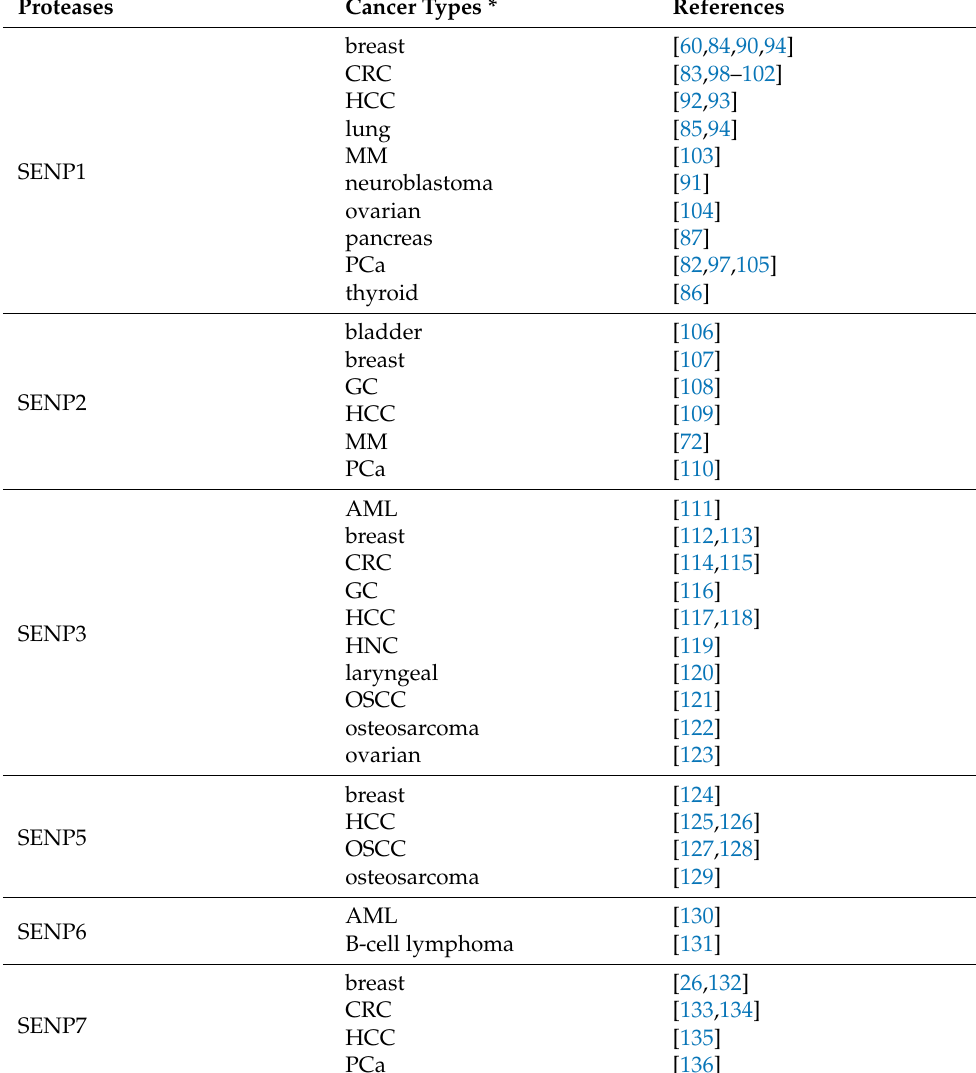
Table 2. SUMO proteases involved in